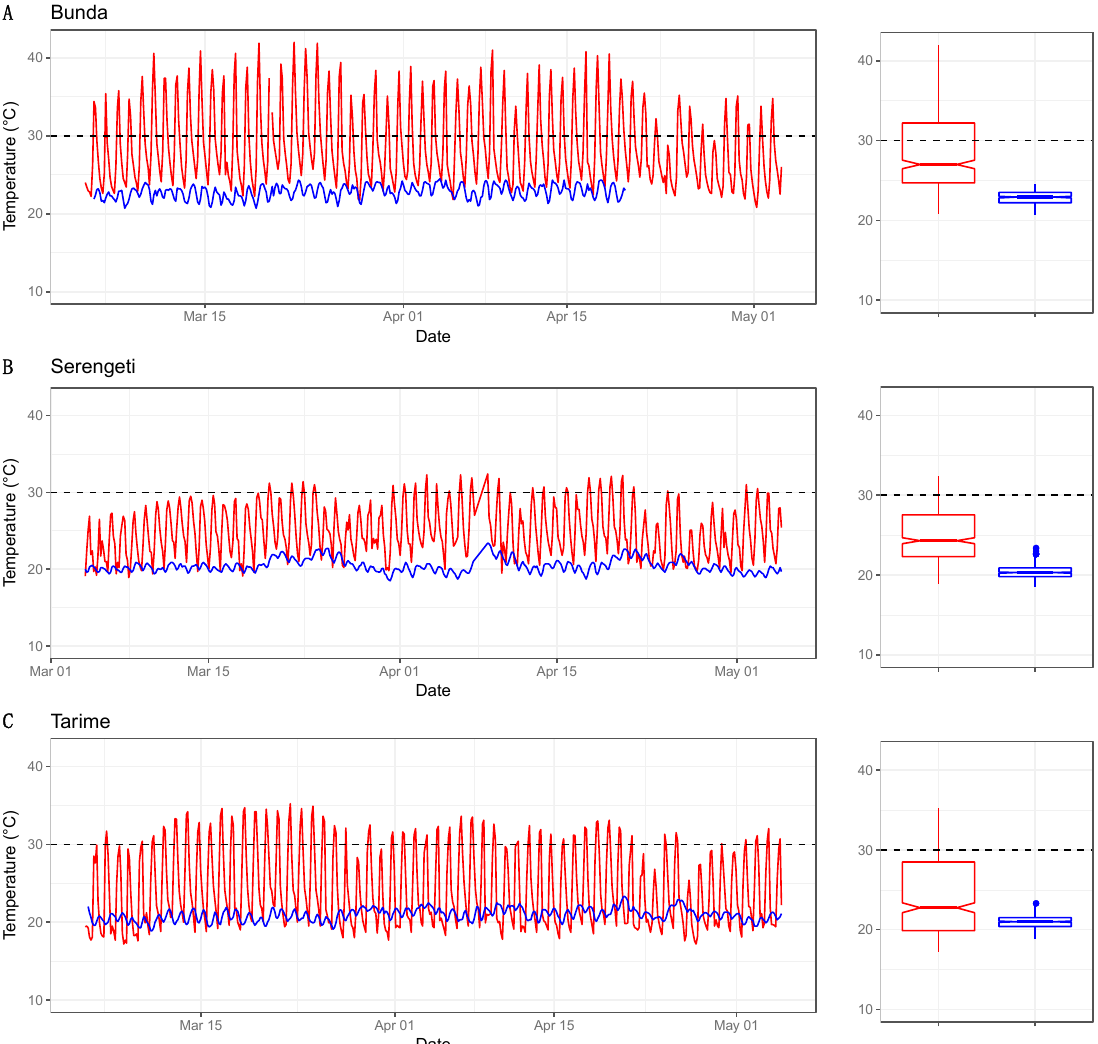
Figure 5. Ambient vs. internal storage temperatures within the Zeepot Clay over a 2-month period in three sites ( A – C ). Time series and boxplots indicate the median and range of temperatures in the three sites. The maximum storage temperature above which the Nobivac TM Canine Rabies vaccine loses potency is indicated by the dashed line. Table 3. The mean ambient temperature and internal temperature of the Zeepot Clay across three sites in the Mara region.